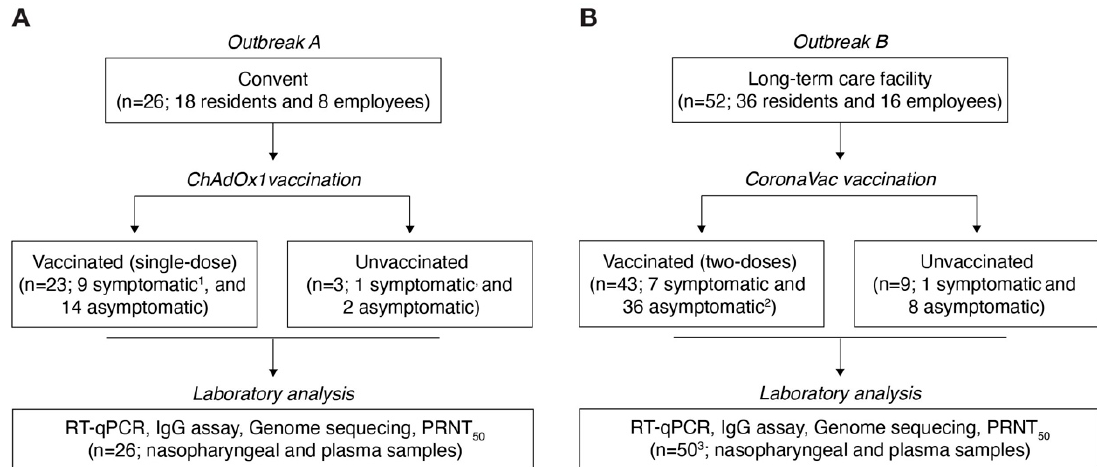
Figure 1. Flow diagram describing the outbreaks reported in this study. Outbreak A in convent ( A ), and outbreak B in long-term care facility ( B ). 1 Includes a nun who was vaccinated with Ad26.COV2.S (Janssen Pharmaceutical Companies, Beerse, Belgium). 2 Includes an employee vaccinated with a single dose of ChAdOx1. 3 Biological samples from a resident (ID: LTC20) and an employee (ID: LTC37) were not collected, the first because the patient was admitted to the hospital with COVID-19 and died 2 weeks later, and the second was paid time off during the collection samples time. Abbreviations: RT-qPCR; real-time quantitative polymerase chain reaction; IgG, immunoglobulin G; PRNT, plaque reduction neutralization tests.